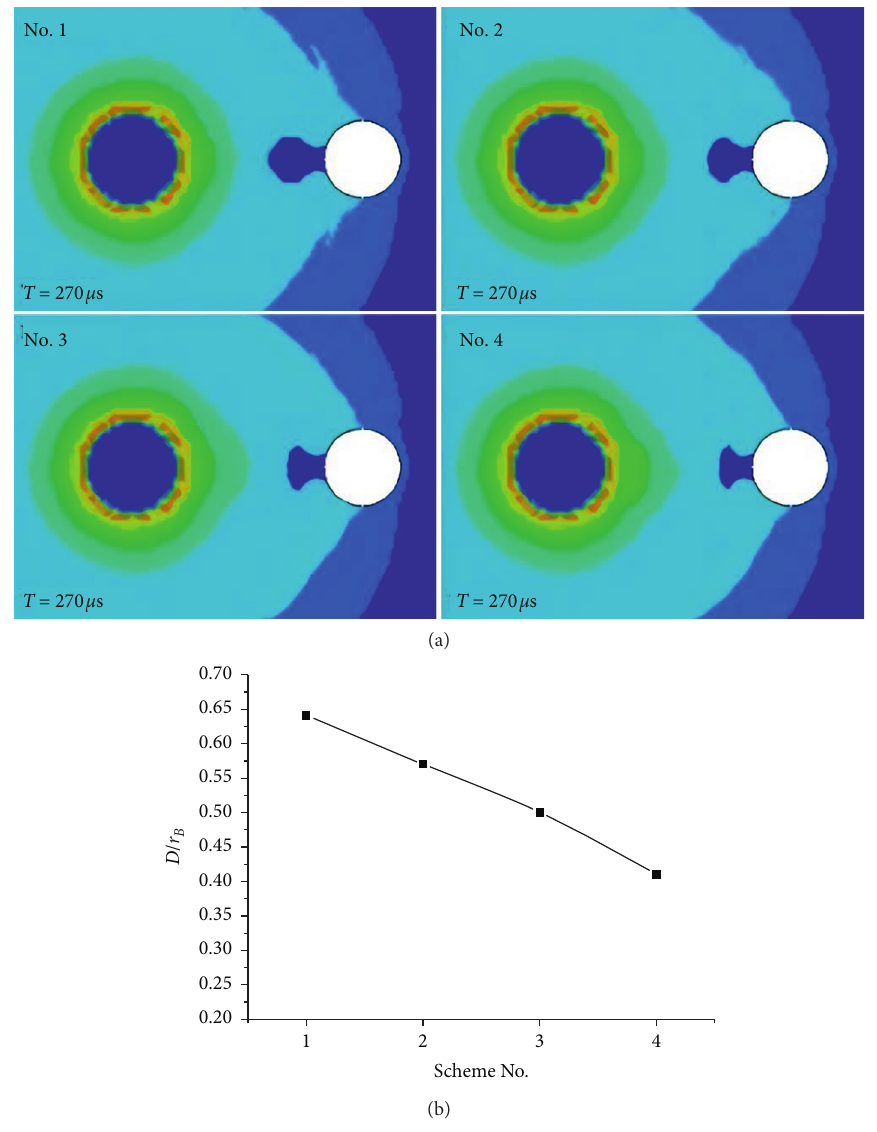
Figure 6: Cloud chart of dynamic stress distribution around the empty hole in combined stress field and curves of changes in tension zone for Scheme II. (a) Cloud chart of dynamic stress distribution in combined stress field. (b) Changes in the tension